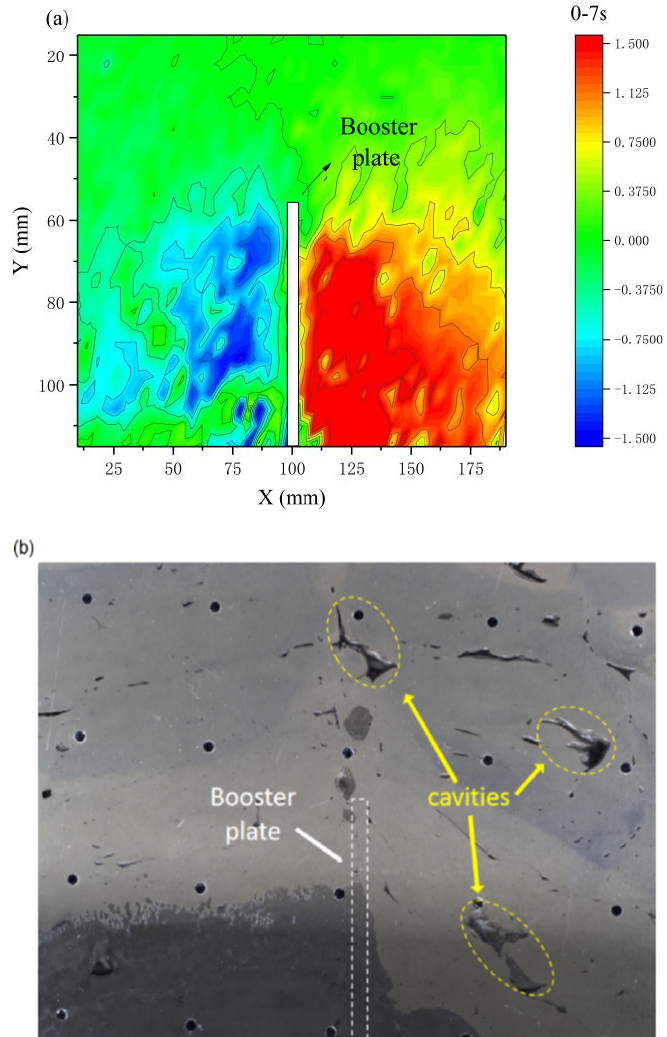
Figure 8. PIV results for a time period of 0~7 s of air boosting: ( a ) coloured contour on horizontal displacement; ( b ) slurry picture taken on time instant t * = 7 s.